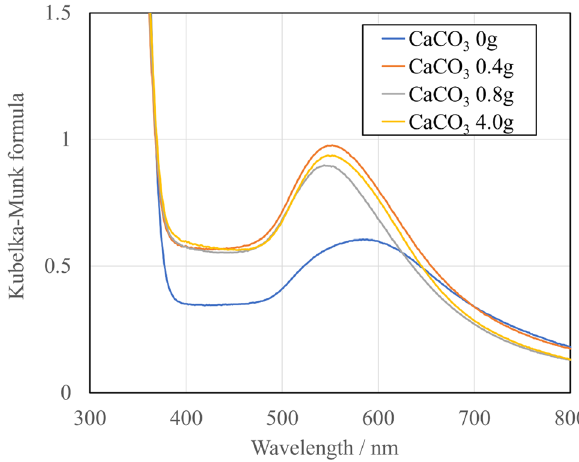
Fig. 9 Kubelka–Munk conversion curve of the catalyst reflectance measurements